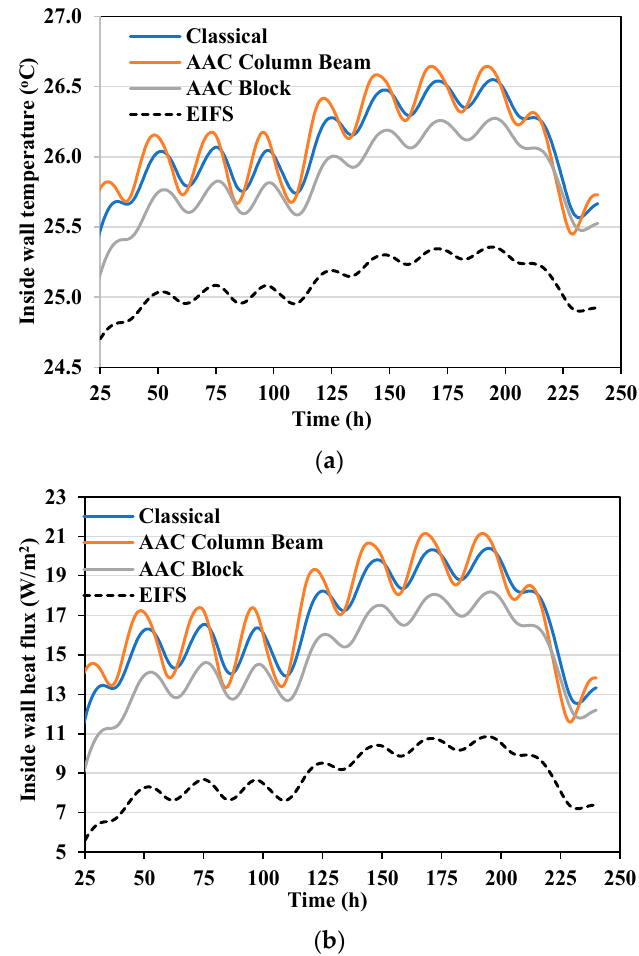
Figure 6. Inside wall temperature and heat flux of the thermal bridges of the roof using tested four walls. ( a ) inside wall temperature, ( b ) inside heat flux.